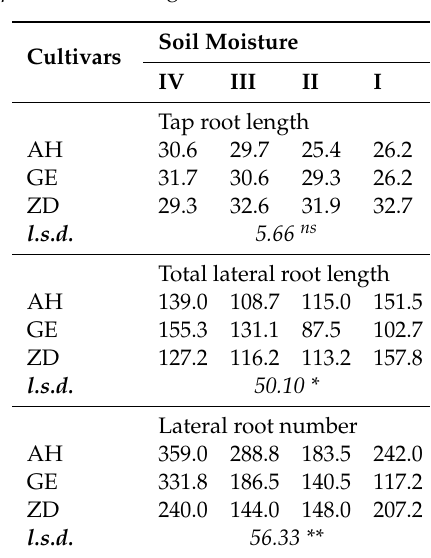
Table 6. Interactions on tap root length (TRL; cm), lateral root length (LRL; cm) and lateral root number (LRN) between cultivars (AH, GE and ZD) and soil moisture treatments (See Table 1 for soil moisture